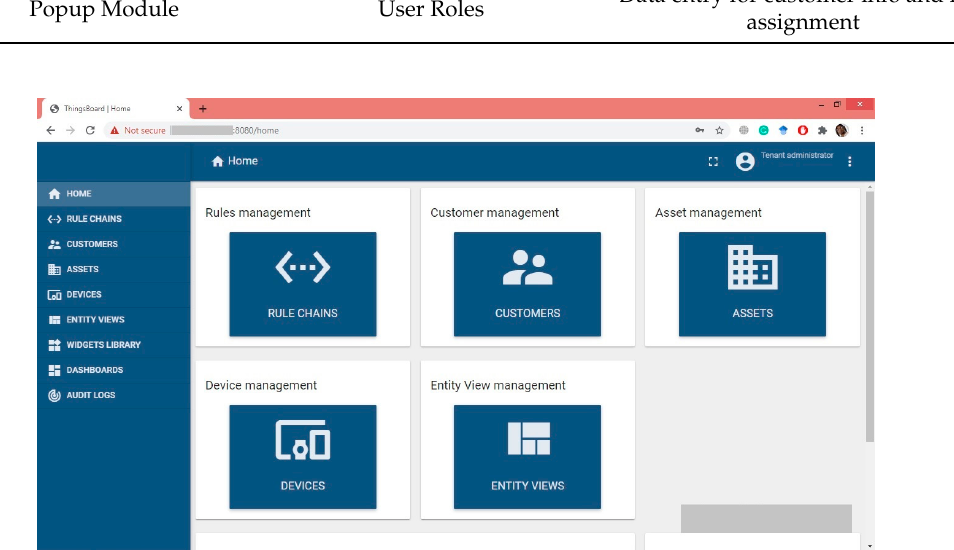
Figure 8 . LIS to RSPI3 connection .